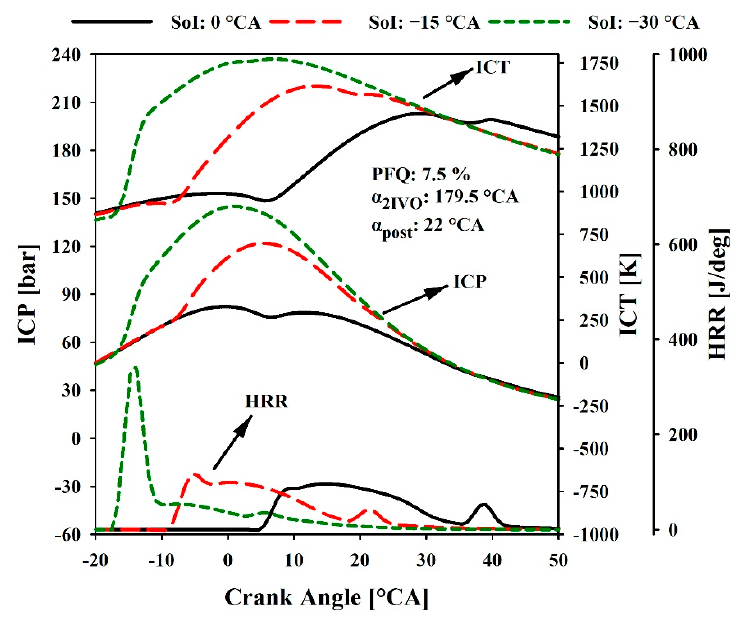
Figure 12. ICP, ICT and HRR patterns for various SoI timings .